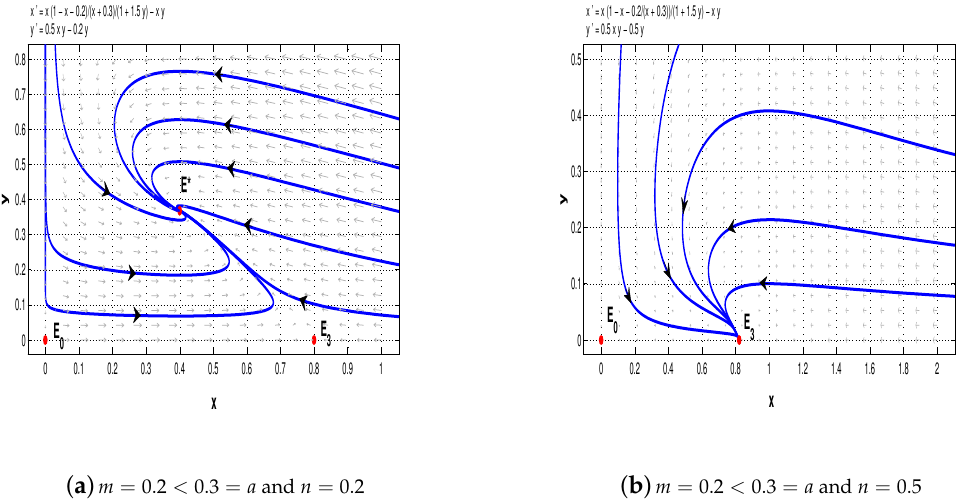
Figure 5. ( a ) With m = 0.2 < 0.3 = a and n = 0.2, E 0 and E 3 are saddle points. ( b ) With m = 0.2 < 0.3 = a and n = 0.5, E ∗ is a stable node.